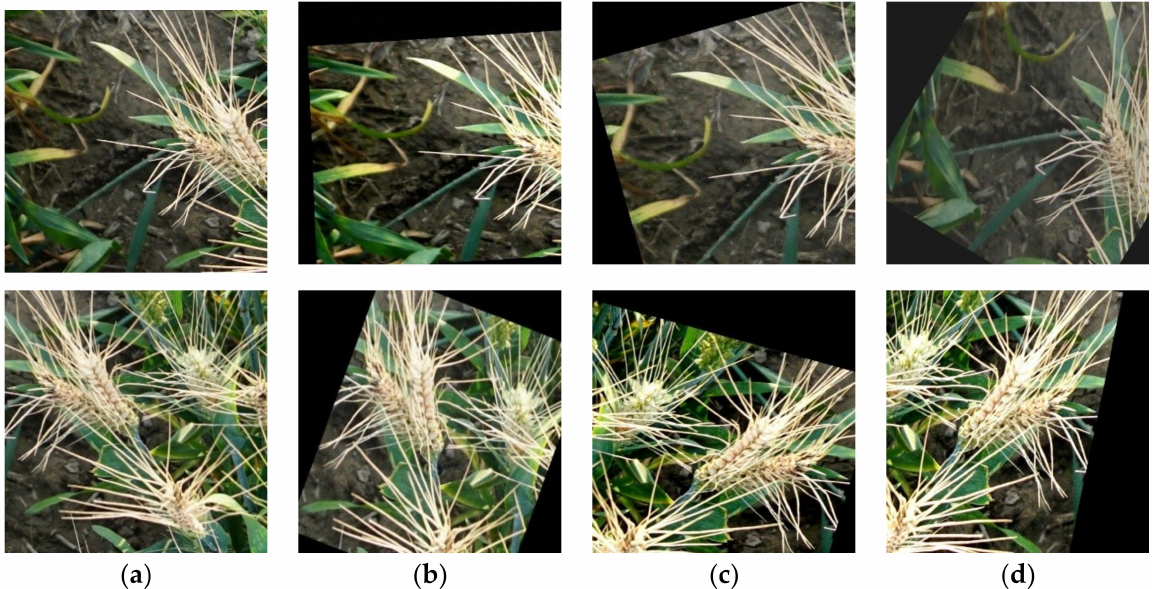
Figure 9. Examples of wheat disease images after image enhancement. ( a ) Original image, ( b ) hor- izontal flipping and cropping, ( c ) cropping and minor Gaussian blurring, and ( d ) cropping and contrast and brightness